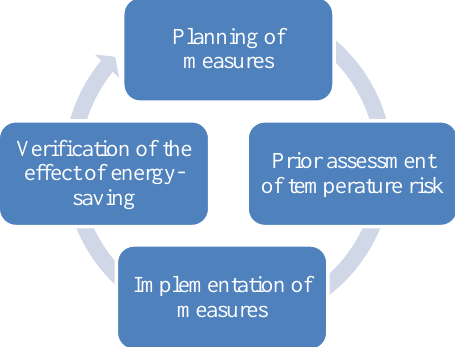
Figure 1. Four-step process of energy saving in a data center.